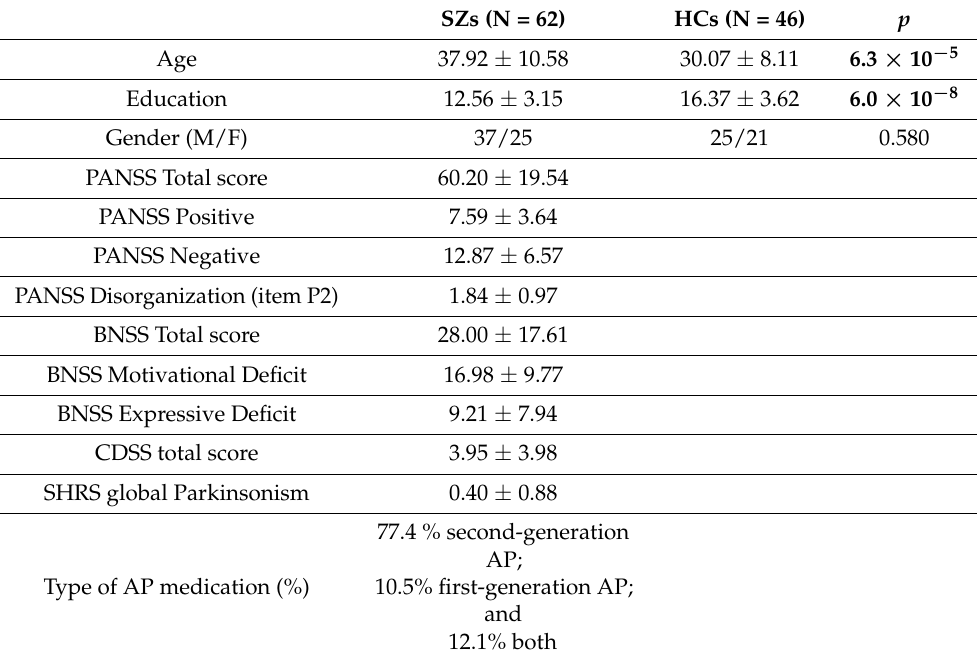
Table 1. Sociodemographic and clinical characteristics of the study sample.